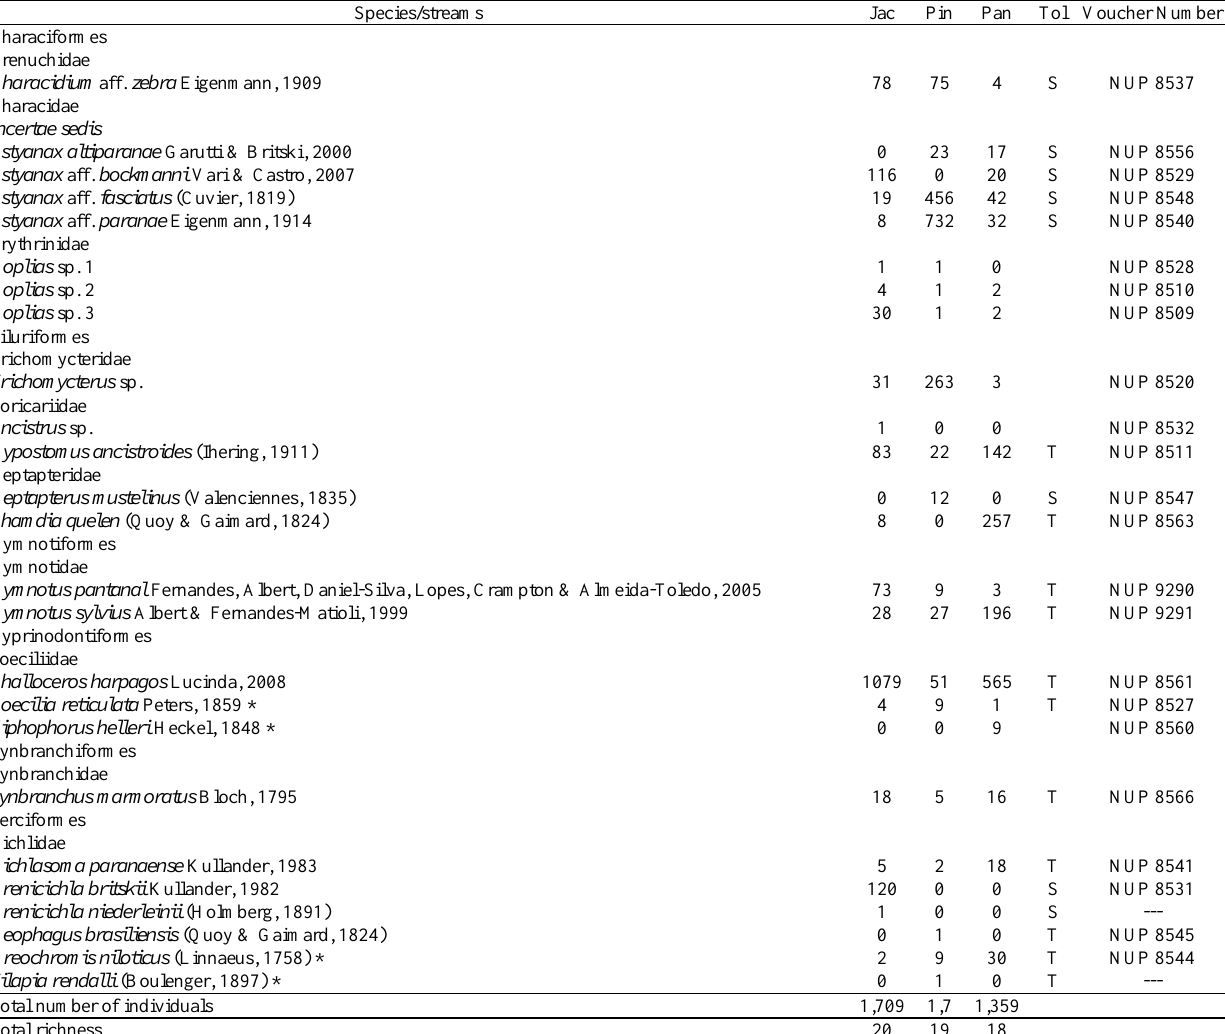
Table 2. List of species and number of individuals recorded along the urbanization gradient in urban streams (Jac, Jacutinga; Pin, Pinheirinho; Pan, Panambi) in the city of Toledo, State of Paraná, southern Brazil, from December 2007 to December 2008. * Non-native species; Tol = Tolerance (T = tolerant; S = sensitive), following Bozzetti & Schulz (2004), Pinto & Araújo (2007), and Casatti et al. (2009,